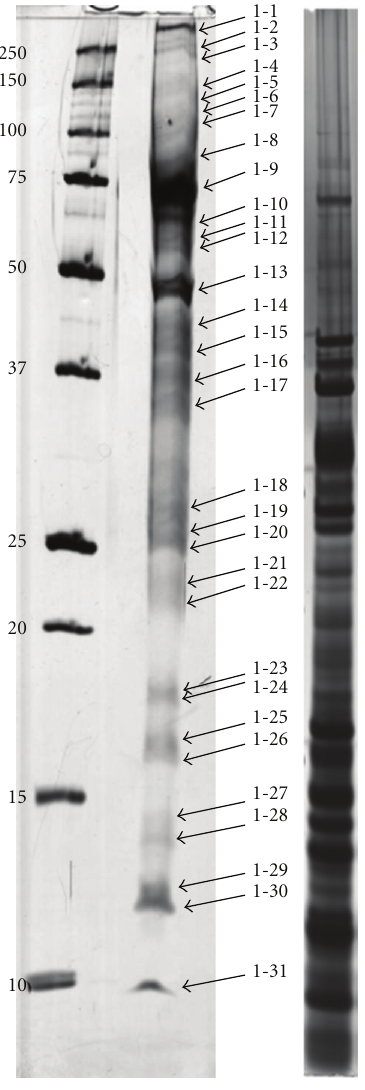
Figure 3: 1D SDS-PAGE image of HNPE conditioned SF-medium (5 μ g/well, silver stained, left-hand side: molecular weight marker, kDa). The gel bands on the middle lane with serial numbers were analyzed by nano-HPLC-ESI-MS/MS. In the 30 bands, 132 proteins were identified. The gel bands on the right-hand side were the cell lysised